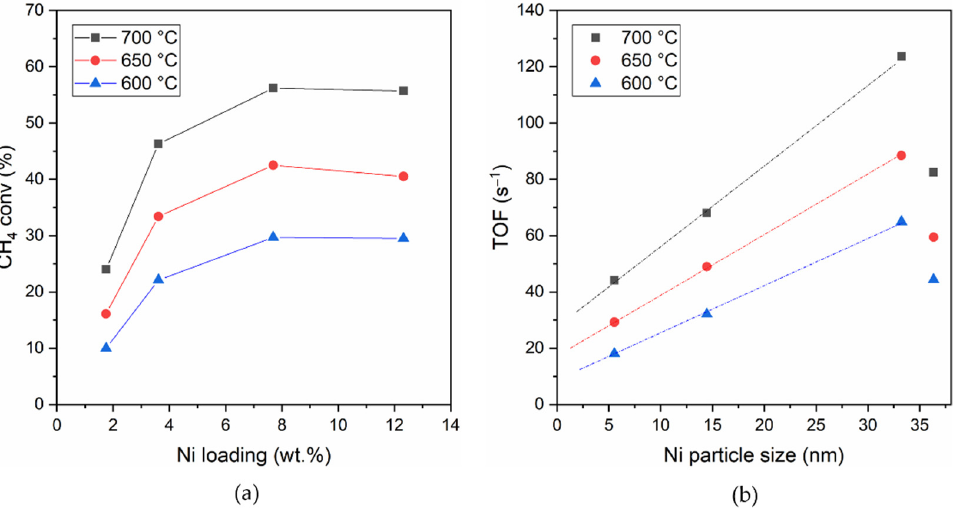
Figure 8. ( a ) CH 4 conversion as a function of nickel content; ( b ) turnover frequency as a function of the average particle size evaluated by H 2 -TPD of the xNiCe catalysts.